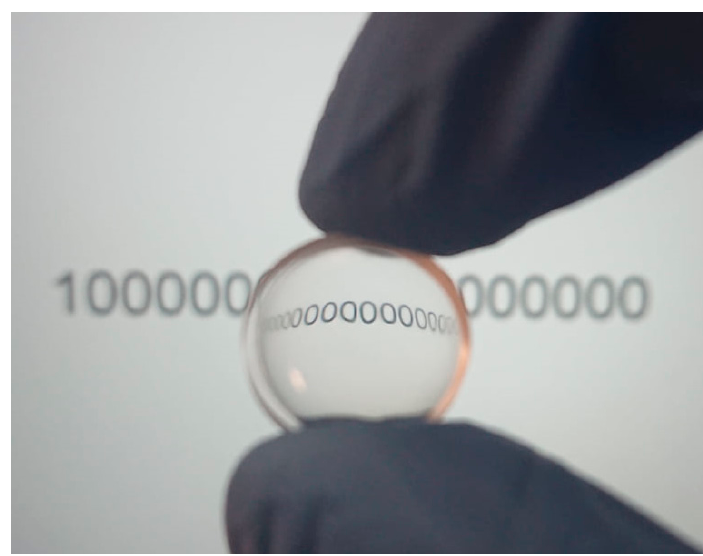
= 22 W, N = 5, v = 620 mm / s and dx = 10 p